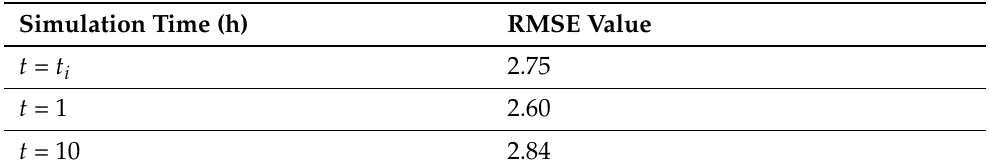
Table 3. Root mean square error (RMSE) obtained from the comparison of this work and the chemo- poroelasticity model.